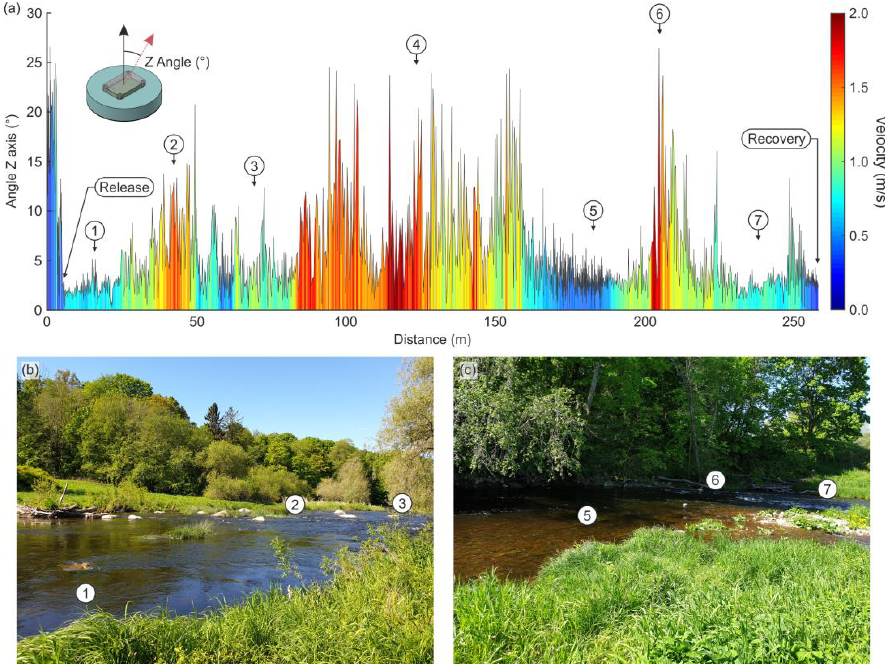
Figure 7. The inclination of the drifter during the studied track (raw data). ( a ) Evolution of the velocity and inclination during the track. This allows the differentiation of areas of different properties within the reach; ( b , c ) different areas and transitions. Numbers link the graph ( a ) with the different river arear ( b , c ).